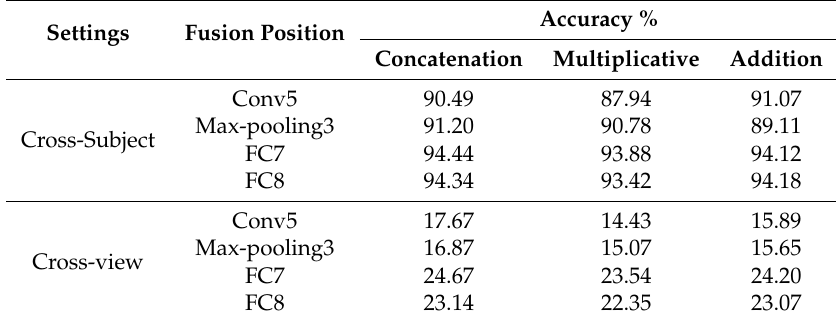
Table 2. Recognition accuracy of a KNN classifier in terms of the NUCLA dataset after two AlexNet networks (spatial) fusion.